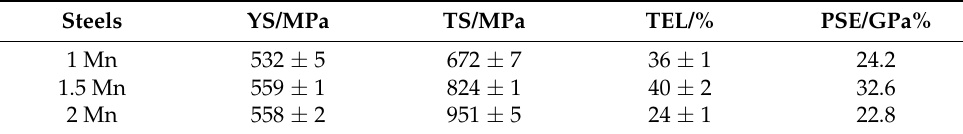
Figure 7. ( a ) Engineering stress-strain curves; ( b ) true stress-strain and corresponding work hard- ening rate curves up to necking of experimental steels. The mechanical properties of industrial QP980 steel are labelled in ( a ), and the inserted map in ( b ) is the magnification of the green dotted rectangle. Table 4. Tensile properties of three δ -TRIP steels.